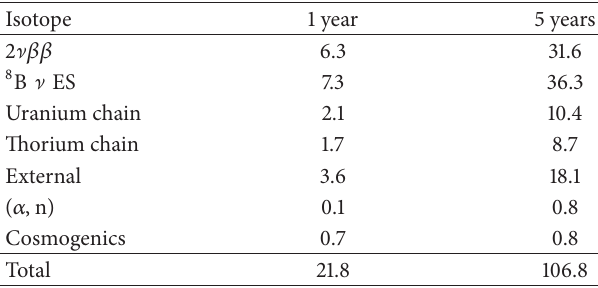
Table 4: Expected background counts in the signal ROI and 3.5 mFV in SNO+ for the first year (year 1) and in 5 years of the 0.3% Te-loading phase. A light yield of 200 Nhits/MeV has been assumed. Cuts have been applied as described in the text.